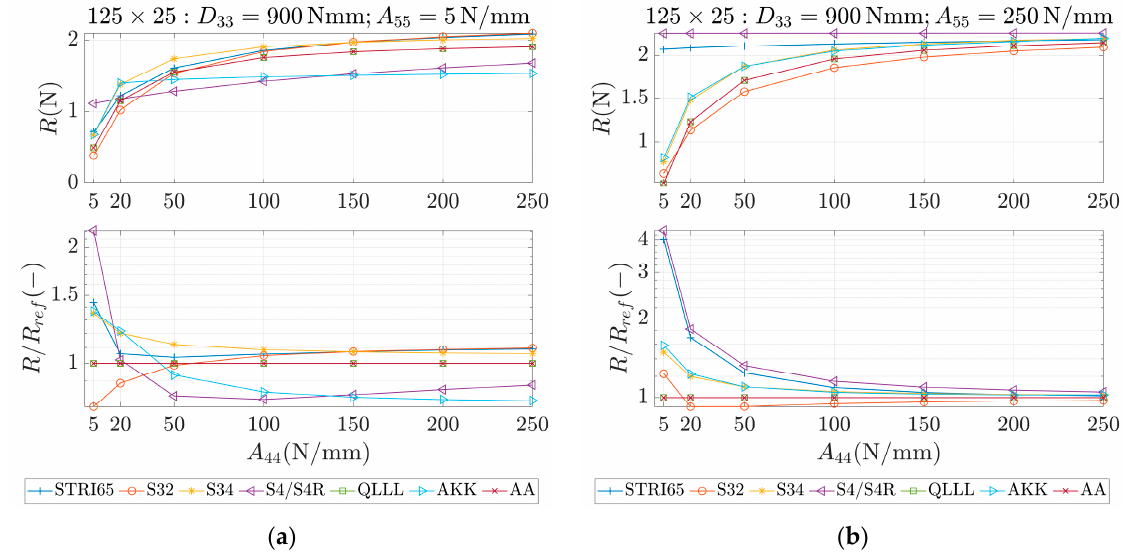
Figure 10. Reactions(firstrow)andreactionstothereference(analytical)solution(secondrow)for125 × 25 sample, D 33 = 450 Nmm and different values of A 55 . ( a ) A 44 = 5 N / mm and ( b ) A 44 = 250 N / mm.